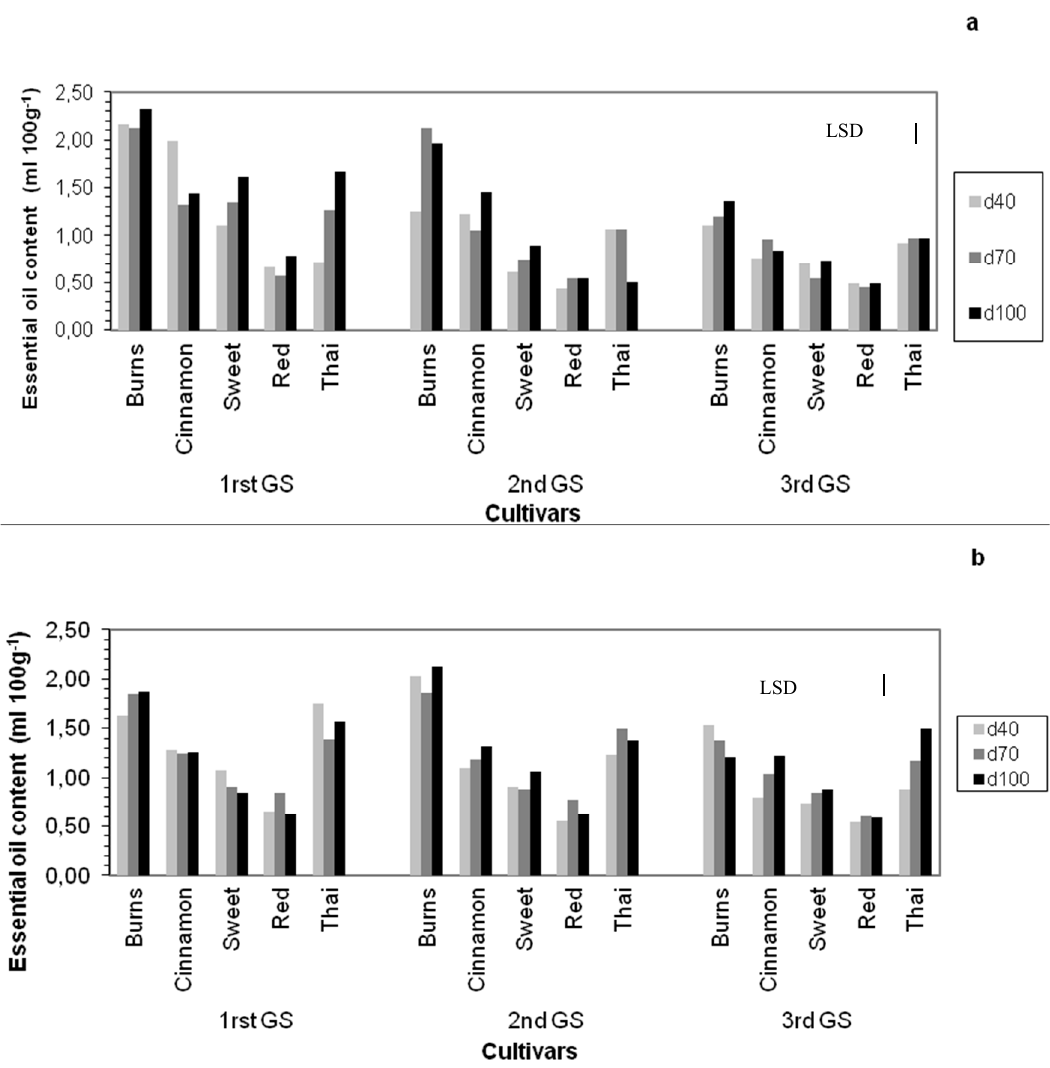
Figure 2. Essential oil content of the five basil cultivars during the three growing stages (GS) (where 1 is for the initiation of flowering, 2 is for the full bloom, 3 is the end of flowering) at the three irrigation levels (d 40 , d 70 and d 100 ) for the two growing seasons 2015 ( a ) and 2016 ( b ). Data presented are mean values; vertical bar corresponds to the least significant difference (LSD= 0.41).